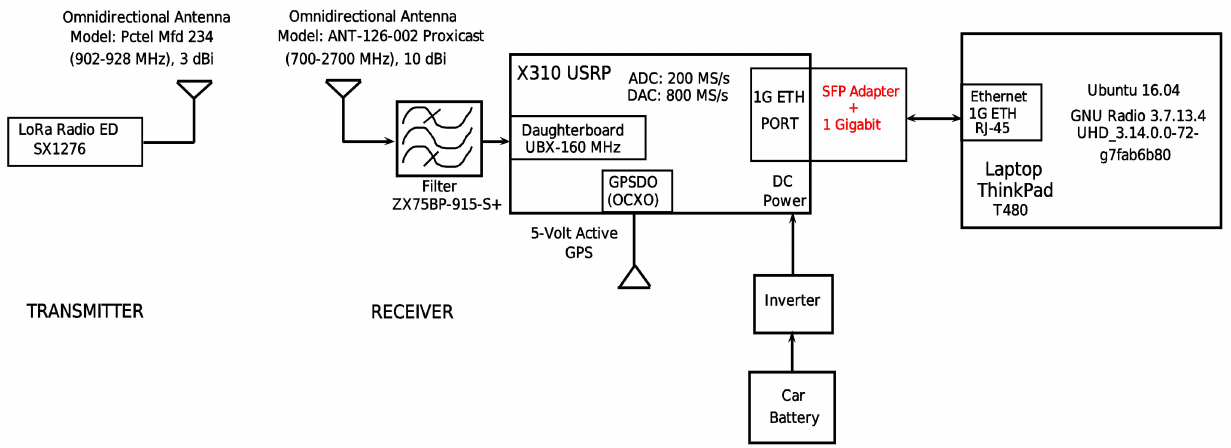
Figure 7. The figure shows the system used for the sounding of the wireless channel. It is composed of a transmitter and a receiver. The LoRa radio was configured as a transmitter whereas in the receiver side the following devices were used: (1) X310 USRP radio, (2) Passband filter to avoid interferences, (3) Laptop to record the received information, and (4) Car battery and inverter to provide electrical current to the receiver